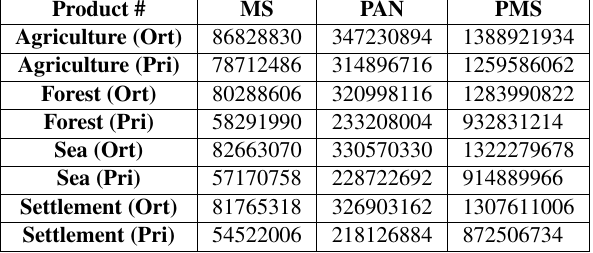
Table 1: File sizes of different land cover datasets (Bytes).